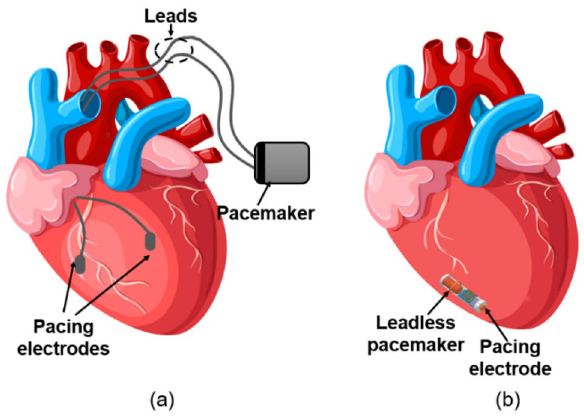
Figure 1. Schematic of the conventional pacemaker vs leadless cardiac Transcatheter Pacing (TCP) system ( a ) conventional pacemaker with pacing leads ( b ) leadless cardiac TCP implanted inside human heart with pacing electrode at the tip (human heart figure is adapted from 12